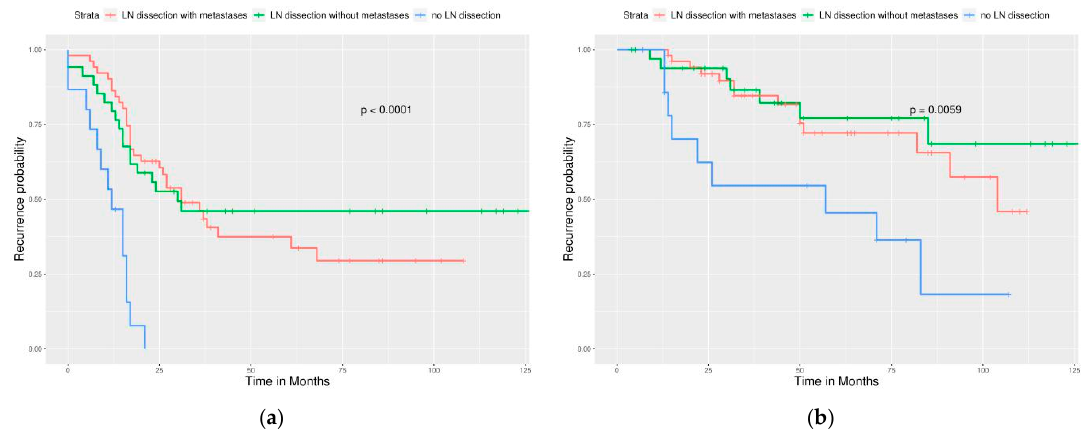
Figure 8. Survival curves by the LN status (Optimally debulked group) ( a ) PFS, p < 0.0001, ( b ) OS, p = 0.0059. LN dissection provided a significantly better outcome of cases, even in an optimally debulked group.